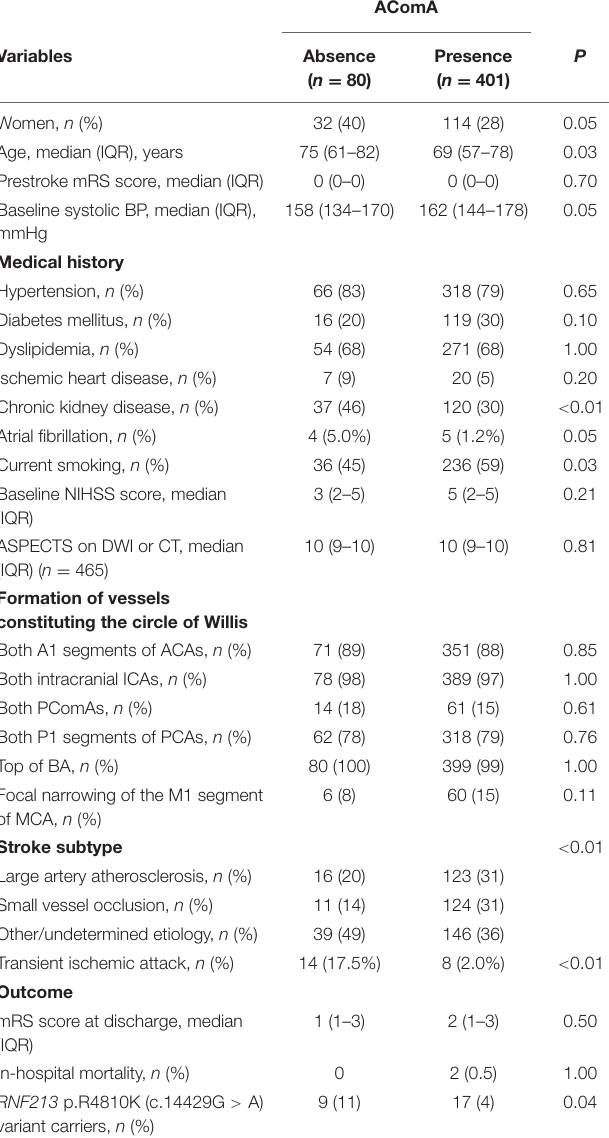
Model 1; adjusted for variables with p < 0.10 (women, age, baseline systolic BP, diabetes mellitus, chronic kidney disease, and current smoking). Model 2; forward–backward stepwise method. AComA,anteriorcommunicatingartery;BP,bloodpressure;CI,confidenceinterval; MCA, middle cerebral artery; OR, odds